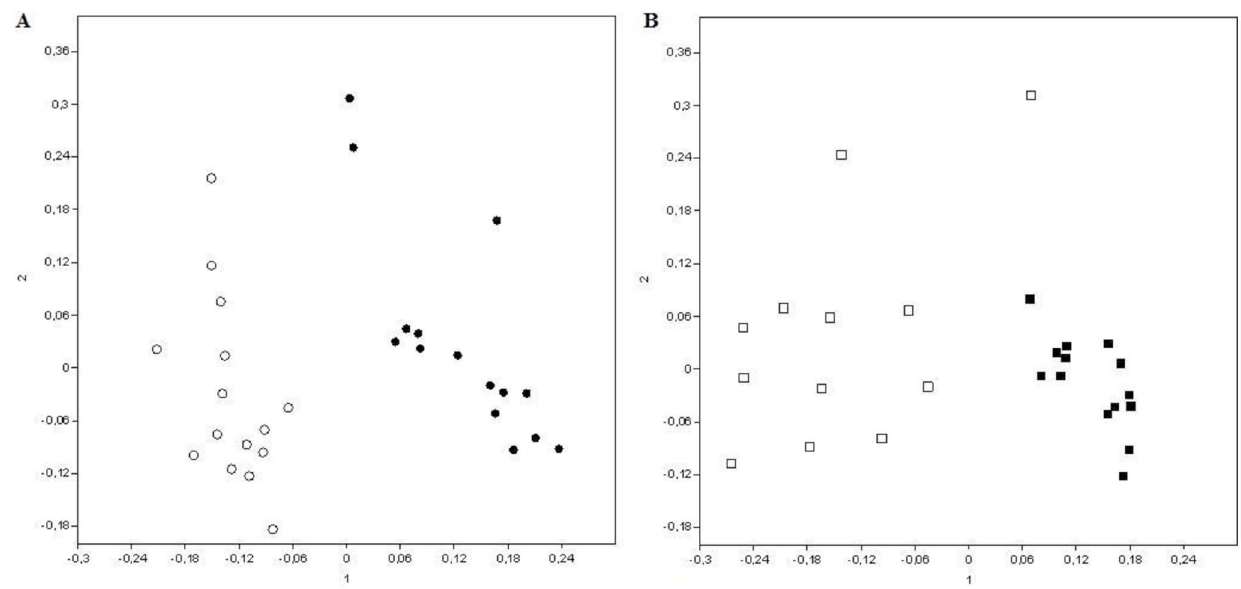
Figure 3. Non-metric multidimensional scaling (NMDS) of bacterial communities determined by T-RFLP, showing the seasonal variation among bulk soil (A) and rhizosphere (B) samples. Bulk soil samples are represented by circles and rhizosphere samples are represented by squares. Rainy season samples are represented by the white color and dry season samples are represented by the black color.